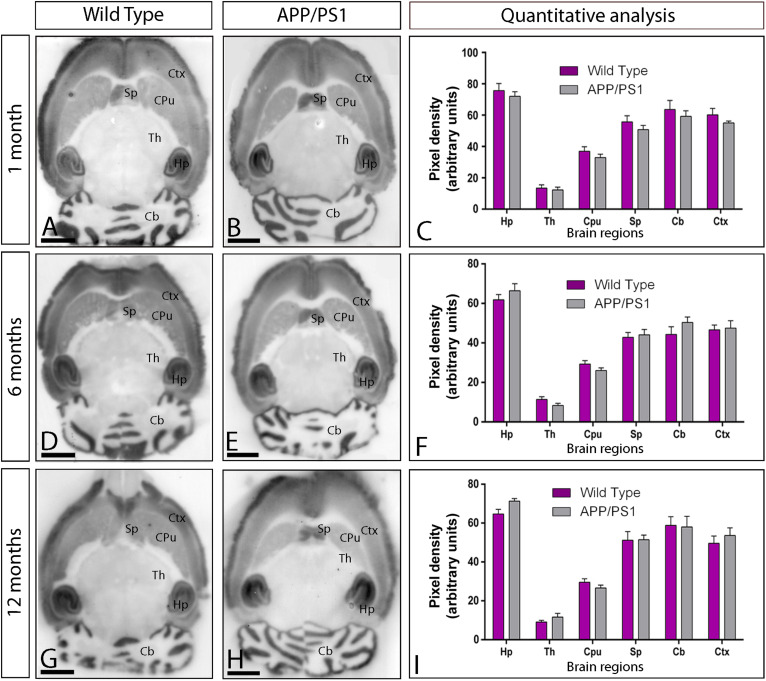
Regional expression of AMPARs in the brain in wild type and APP/PS1 mice. (A–I) Expression of GluA1–4 proteins was visualized using histoblots of horizontal brain sections at 1, 6, and 12 months of age in wild type and APP/PS1 mice, using an affinity-purified anti-GluA1–4 antibody. AMPAR expression in different brain regions was determined by densitometric analysis of the scanned histoblots (C,F,I). The highest level of AMPAR expression was detected in the hippocampus (Hp), followed by the cerebellum (Cb), cortex (Cx), and septum (Sp). Lower expression levels were detected in the caudate putamen (CPu) and the thalamus (Th). Densitometric analysis showed no differences in AMPAR expression in APP/PS1 mice compared to age-matched wild type controls. Error bars indicate SEM. Scale bars: 0.2 cm.